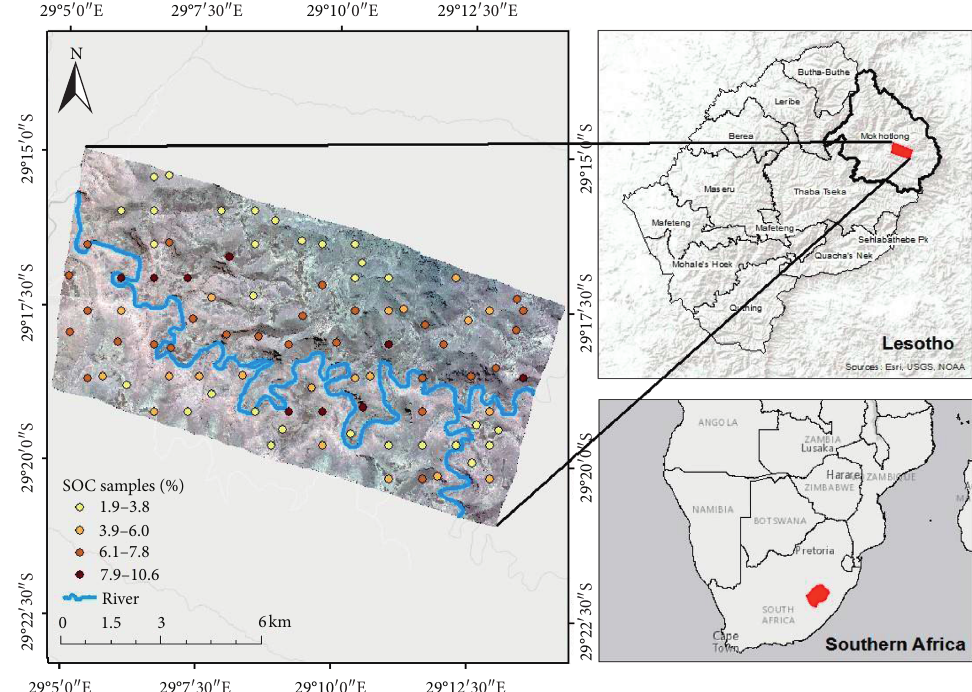
Figure 1: Location of the study area in eastern Lesotho, showing the positions of soil samples/ASD data points, and soil organic carbon values (g 100g − 1 ).